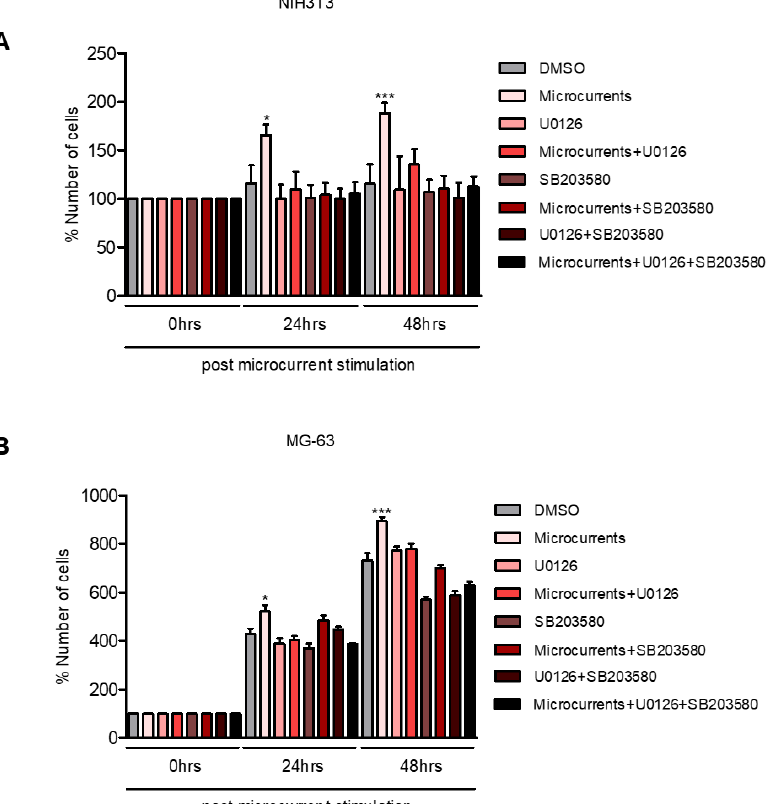
Figure 3. Microcurrent stimulation enhances the cellular proliferation rate in the fibroblasts and osteoblasts. ( A ) Graph depicts the proliferation rate of NIH3T3 cells, after the stimulation with microcurrents, in the presence and absence of U0126 or SB203580 or both inhibitors, in different time periods. ( B ) Graphical representation of the proliferation rate of MG-63 cells, following the stimulation with microcurrents and the treatment with U0126 or SB203580 or both inhibitors. (* p < 0.05, *** p < 0.005, N = 3, n = 3, microcurrent stimulation vs. control).